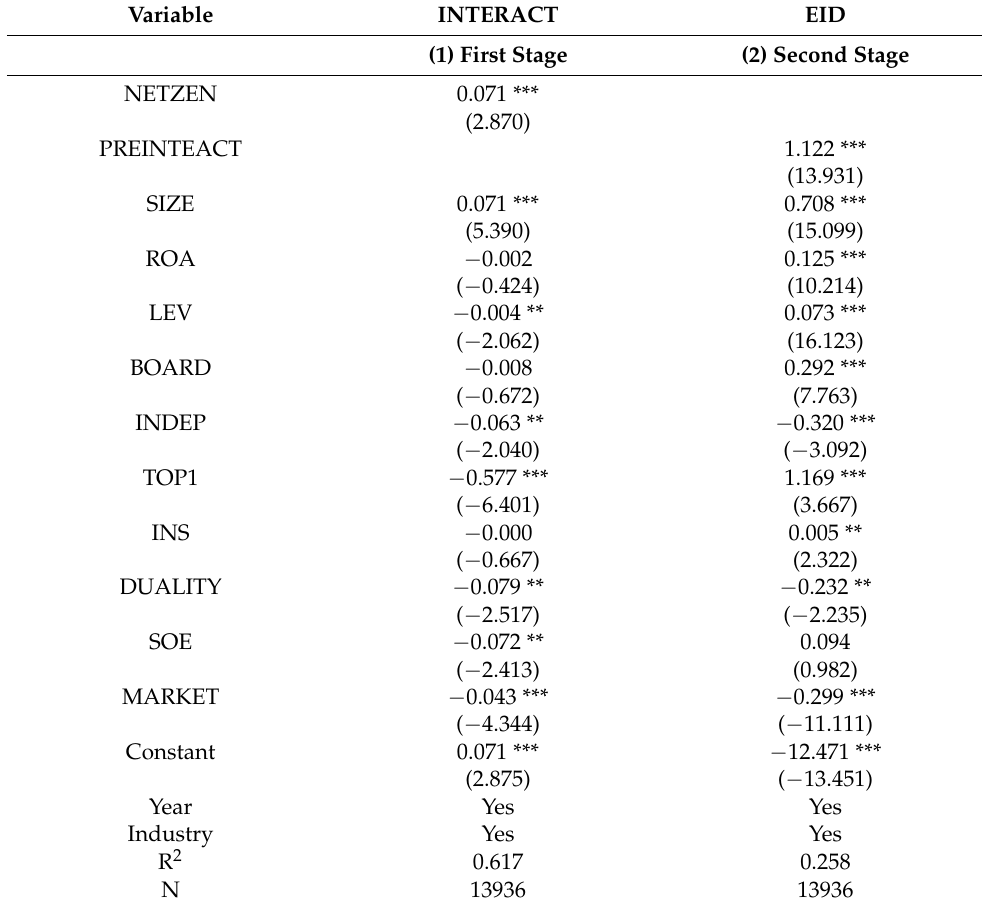
Table 7. Two-stage least squares (2SLS) regression